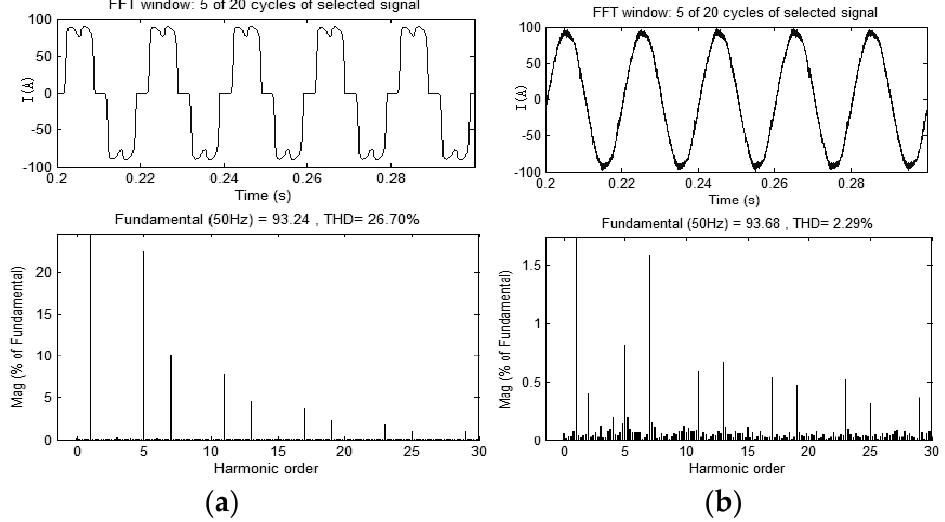
Figure 6. Simulation waveforms of APF with source current control method. ( a ) Load current and its distortion rate before APF application; ( b ) Source current and its distortion rate after APF application.